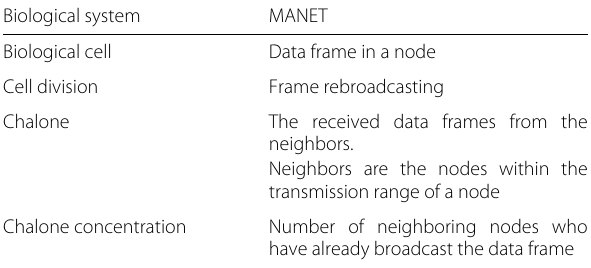
Table 4 Mapping from biological system to MANET Biological system MANET Biological